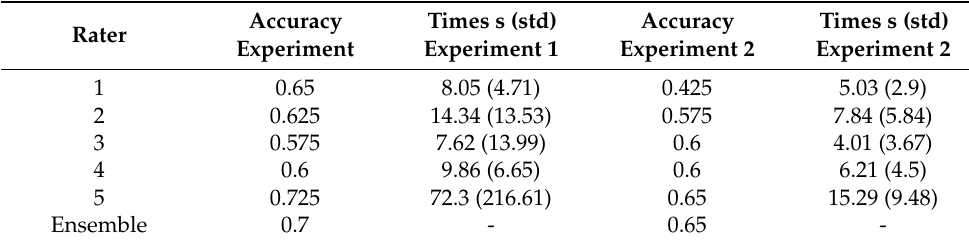
Table 1. Results of the visual Turing test (std indicates ± 1 standard deviation, n = 40).